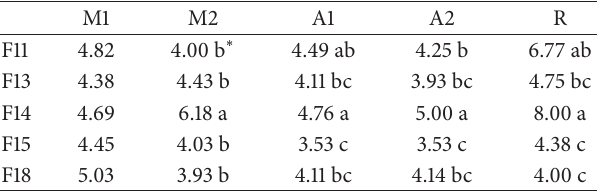
Within a column, means followed by different letters are different at 𝑝 = 0 . 05 .